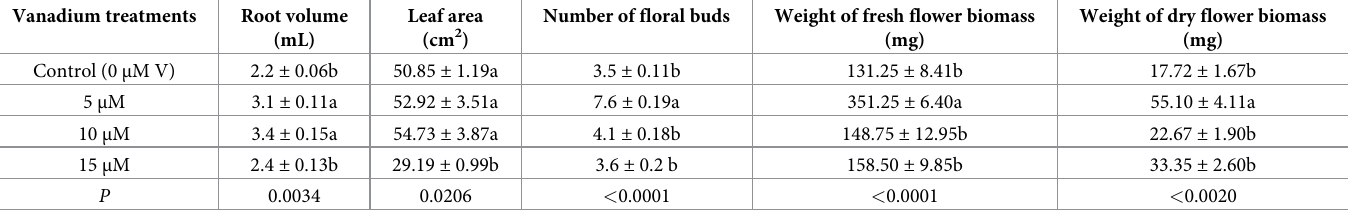
Table 1. Root volume, leaf area, floral buds, and weight of fresh and dry flower biomass in pepper plants grown during 28 days in nutrient solutions containing dif- ferent concentrations of vanadium (V). Vanadium